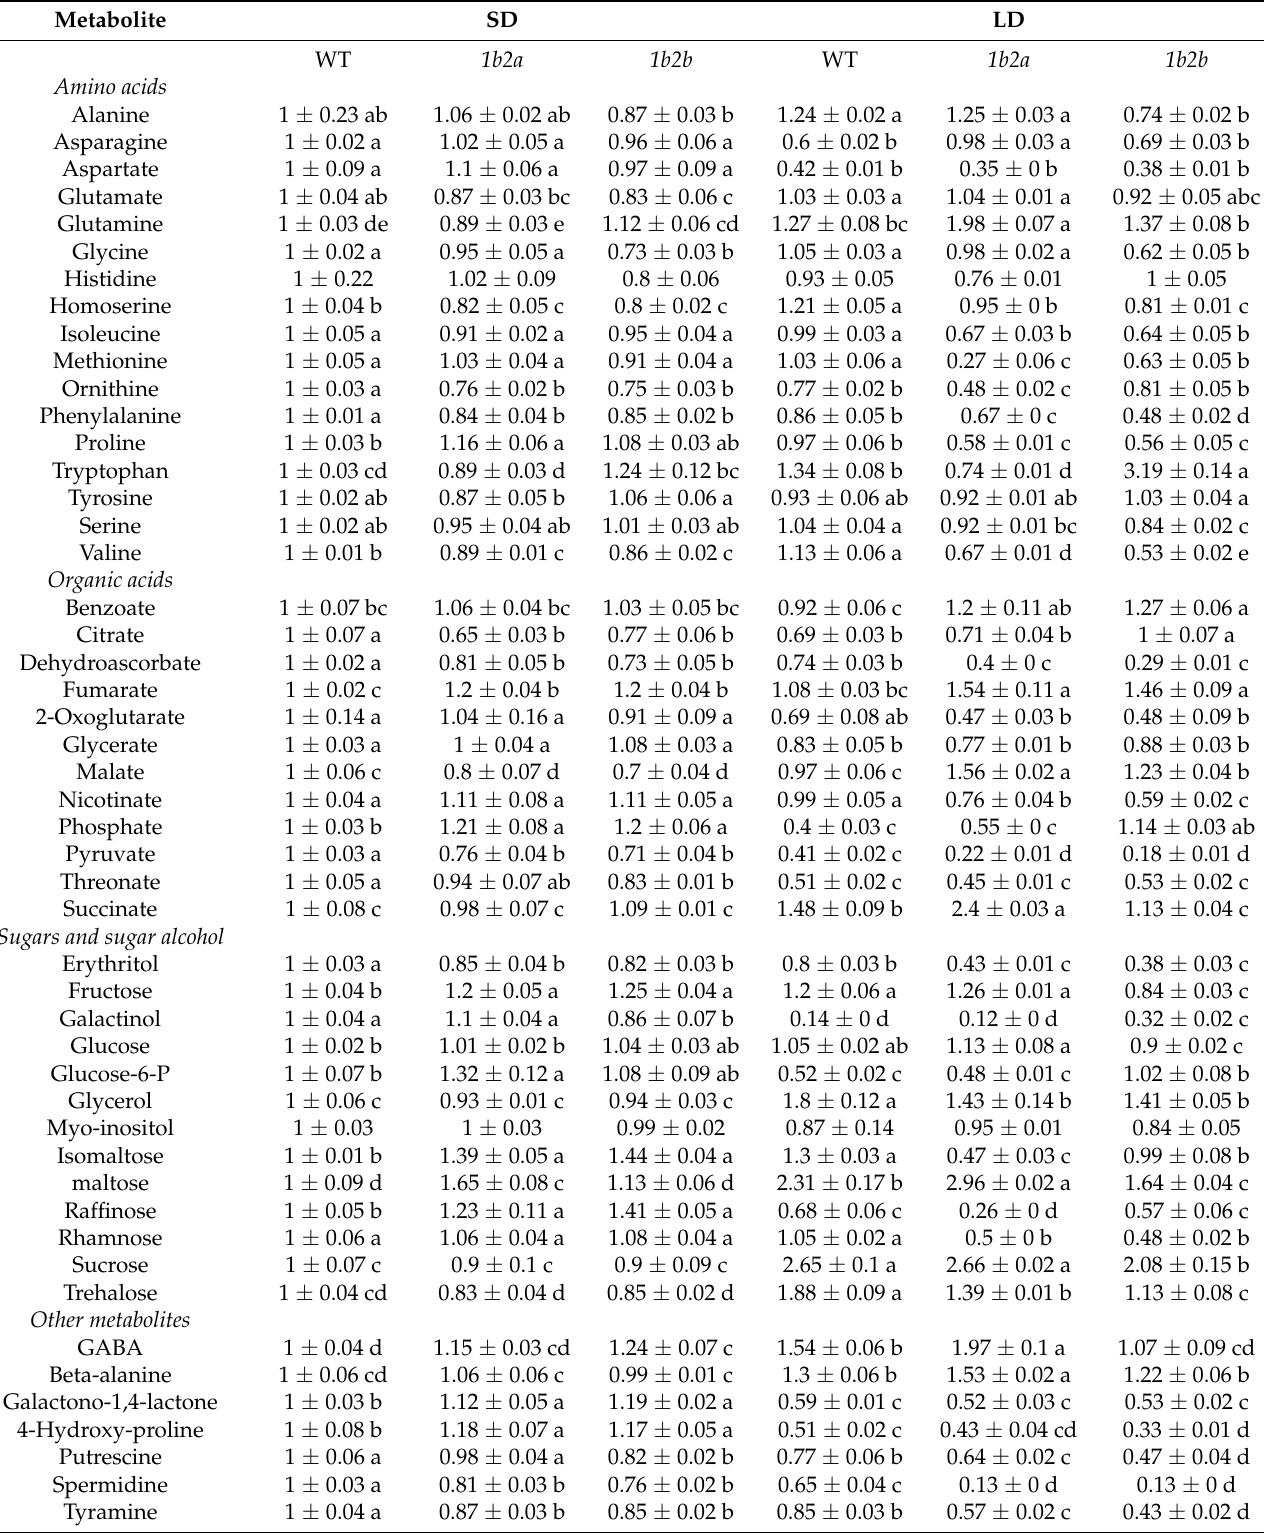
Table 2. Relative metabolite levels in leaves of WT and cytc mutant plants grown under short-day (SD) and long-day (LD) photoperiods. Data are presented as means ± SE for three to five biological replicates normalized to the mean level of the WT plants under SD. Different letters denote significant differences ( p < 0.05) between genotypes and